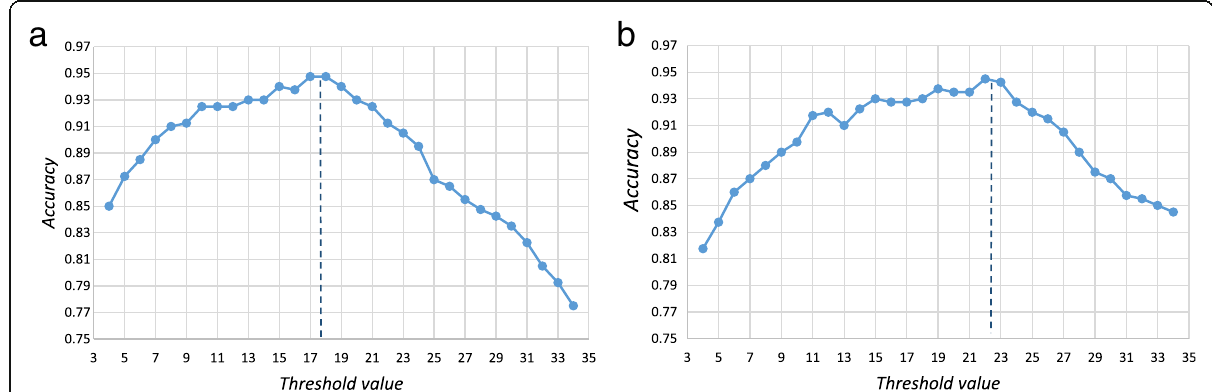
Fig. 6 Line chart of prediction accuracy changes and threshold. a Prediction accuracy changes and threshold with 200 keywords. b Prediction accuracy changes and threshold with 300